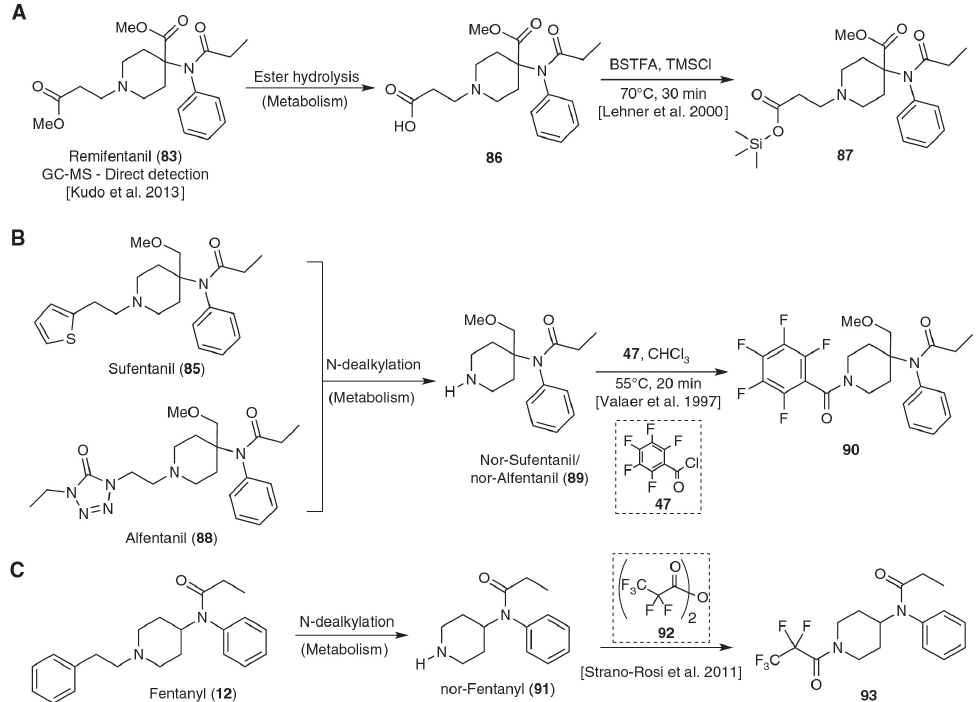
Figure 16: Derivatization of products arising from the hydrolytic and/or metabolic breakdown of various fentanyl-related compounds. The use of fluorinated derivatization tags greatly enhances the detection of these species due to the unsur- passed electron-capture abilities of the fluorine